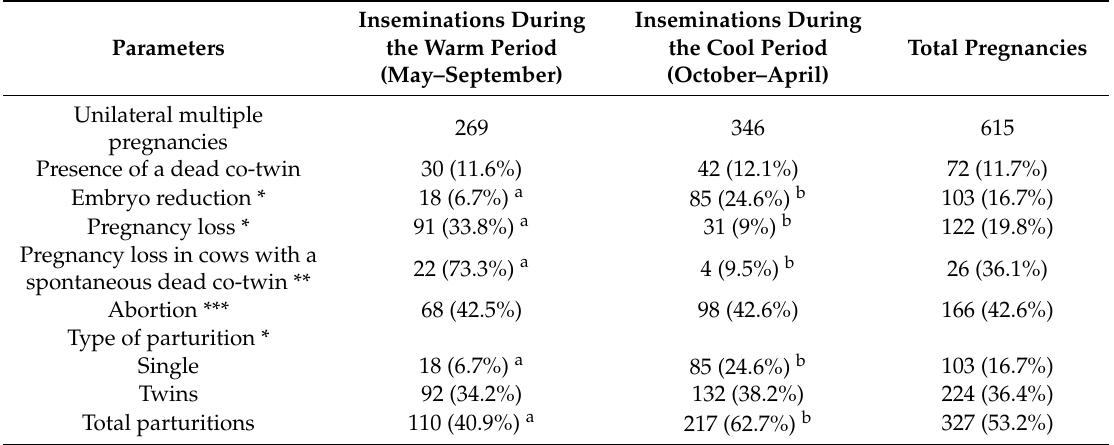
Table 2. Reproductive performance of unilateral multiple gestations during the warm and cool periods. Inseminations During Parameters the Warm